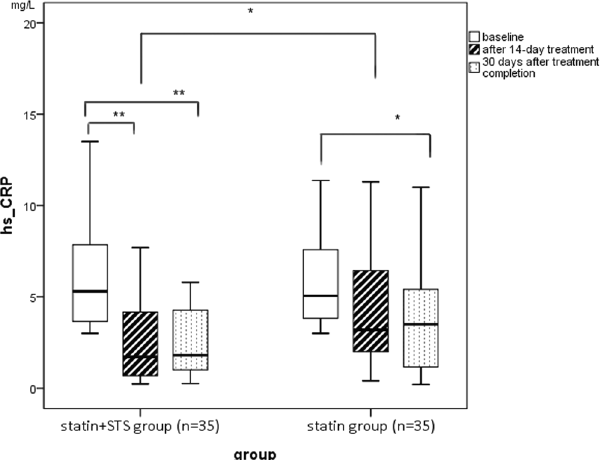
Figure 3. Comparison of hs-CRP level between groups at baseline, after 14-day treatment, and at 30 days after completion of treatment. * Statistically significant, p < 0.05. ** Statistically significant, p < 0.01. hs-CRP, high- sensitivity C-reactive protein; STS, sodium tanshinone IIA sulfate.